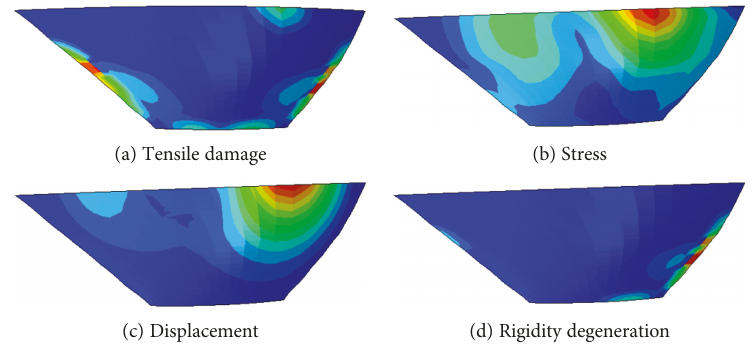
Figure 9: Dynamic response distribution of arch dam at t = 4 721 s .